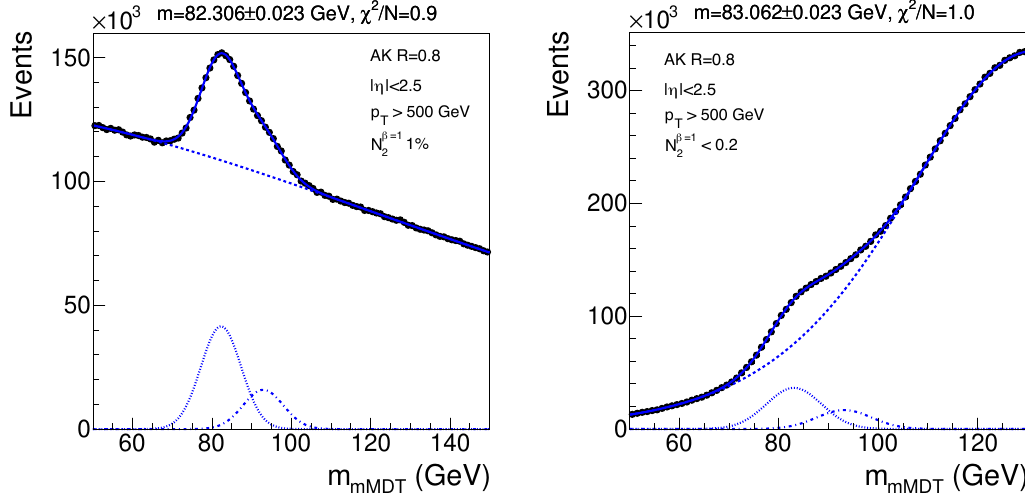
Figure 4 . Simultaneous (cid:12)t of the W + Z signal shape and the functional form parametrizing the background to a distribution of the mass m mMDT of the leading jet in the event from simulated signal and background pseudo-data corresponding to an integrated luminosity of 3000/fb. The left plot requires a decorrelated N (cid:12) =1 1% tagger, the right plot is after a selection of N (cid:12) =1 2 (cid:12)tted value of the W mass peak m W and its statistical uncertainty is quoted on top of the (cid:12)gure together with the (cid:31) 2 per degree of freedom, N , of the (cid:12)t. succeed in retaining events with the leading jet passing p T > 500 GeV and the decorrelated N (cid:12) =1 1% 2